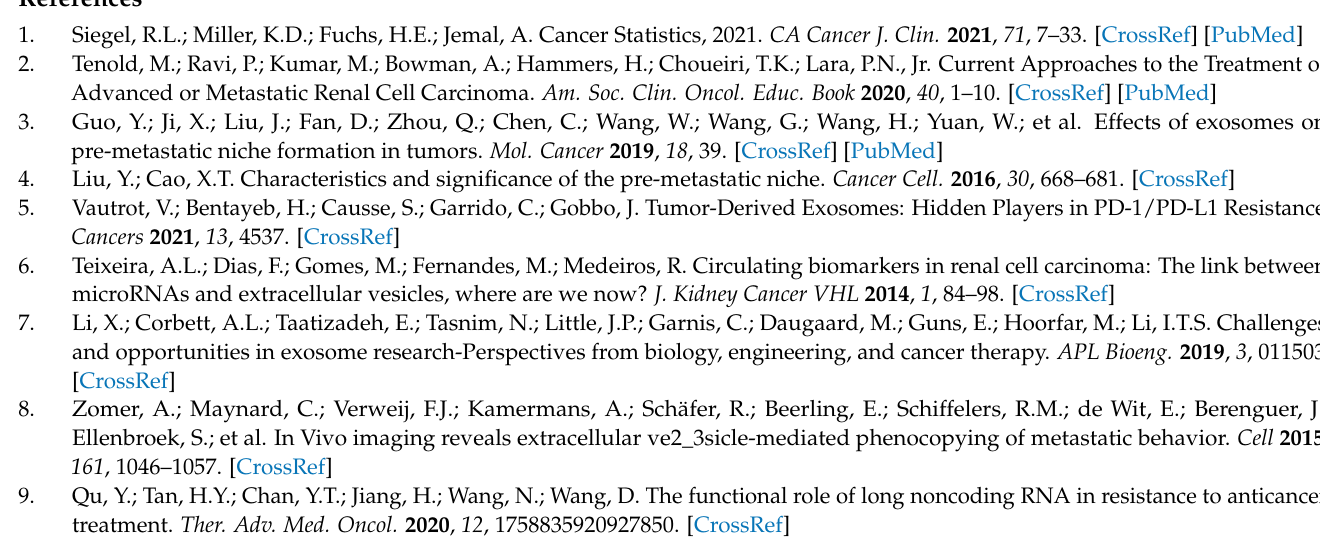
blot, Table S1: Gene, primer orientation, primer sequence, Table S2: Comparison of exosome protein concentration and particle